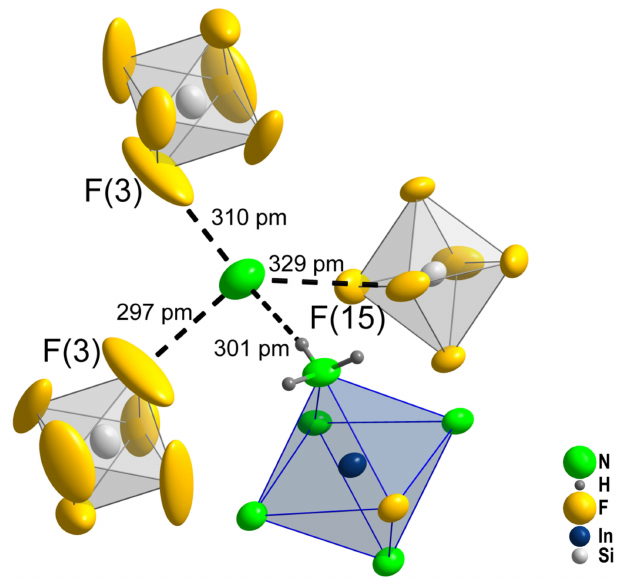
Figure 11. Coordination geometry of the N(14)H 3 molecule together with the N · · · F bond length of the hydrogen bonds (dashed lines).